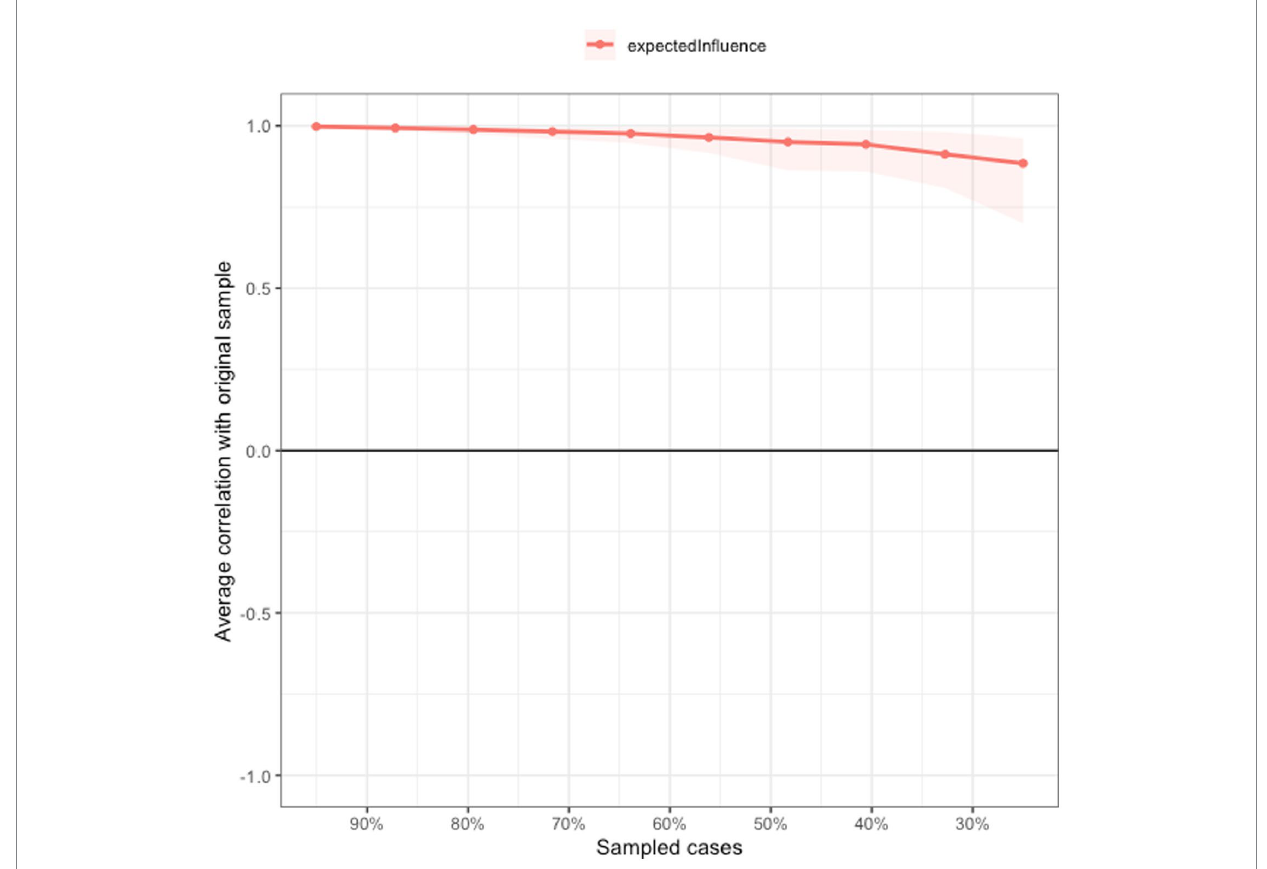
FIGURE 3 Network stability of depressive symptoms among Macau residents during the 618 COVID-19